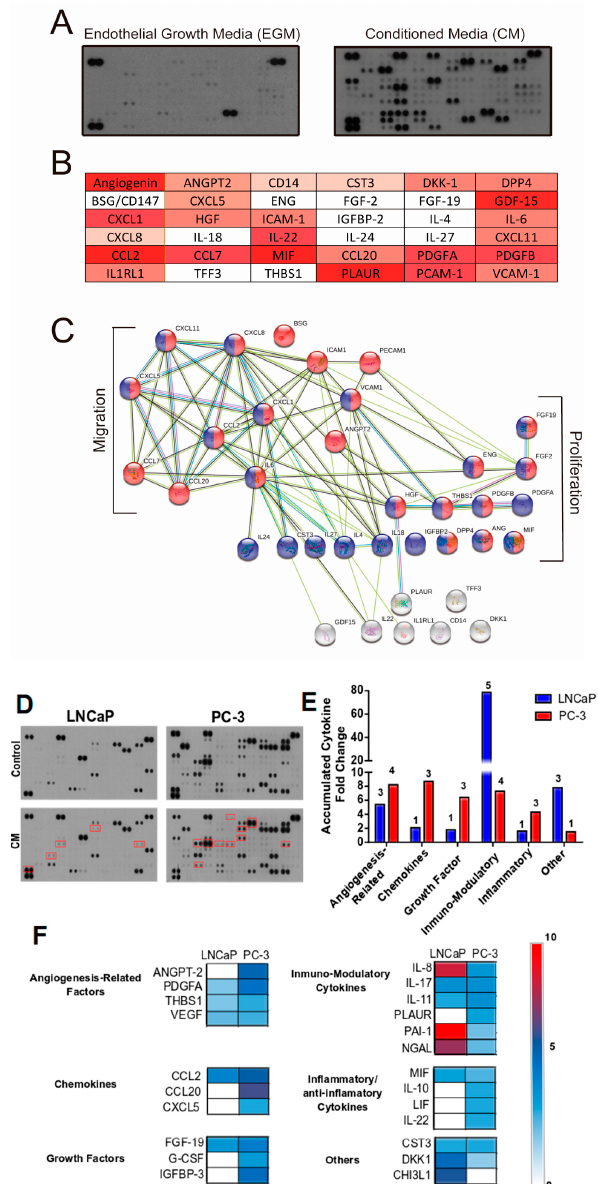
Figure 5. Secreted factors involved in cross-talk communications between endothelial and prostate cancer cells. Cytokine expression profiles in the CM derived from endothelial cells and cell cultures of CaP cells exposed to CM from endothelial cells. ( A ) Cytokine array of CM derived from HUVEC (right panel) and endothelial growth media “EGM” (left panel). ( B ) Graphical representation of the fold-change of cytokines in the CM derived from HUVEC. ( C ) A protein–protein interaction network map for the 36 secreted factors was generated using the STRING program. Proteins involved with cell migration (red) and cell proliferation (blue) are colored. ( D ) Cytokine array of the cell supernatants of PC-3 and LNCaP cells (Top panel) and PC-3 and LNCaP cells exposed to endothelial cell CM (bottom). The red squares indicate the factors that increase with the conditioned medium. ( E ) Graphical representation of the total accumulated fold-change of cytokines in the cell supernatant of PC-3 cells compared to LNCaP cells. ( F ) Representation of secreted proteins that are increased by incubation with endothelial cell CM. The proteins are divided according to their biological function. White squares indicate factors not increased, and dark red squares indicate the maximal induction fold (50 × ). The density of the images was analyzed by ImageJ software and cytokines and growth factors that demonstrated increases of 1.5-fold, or more, relative to the control were scored as